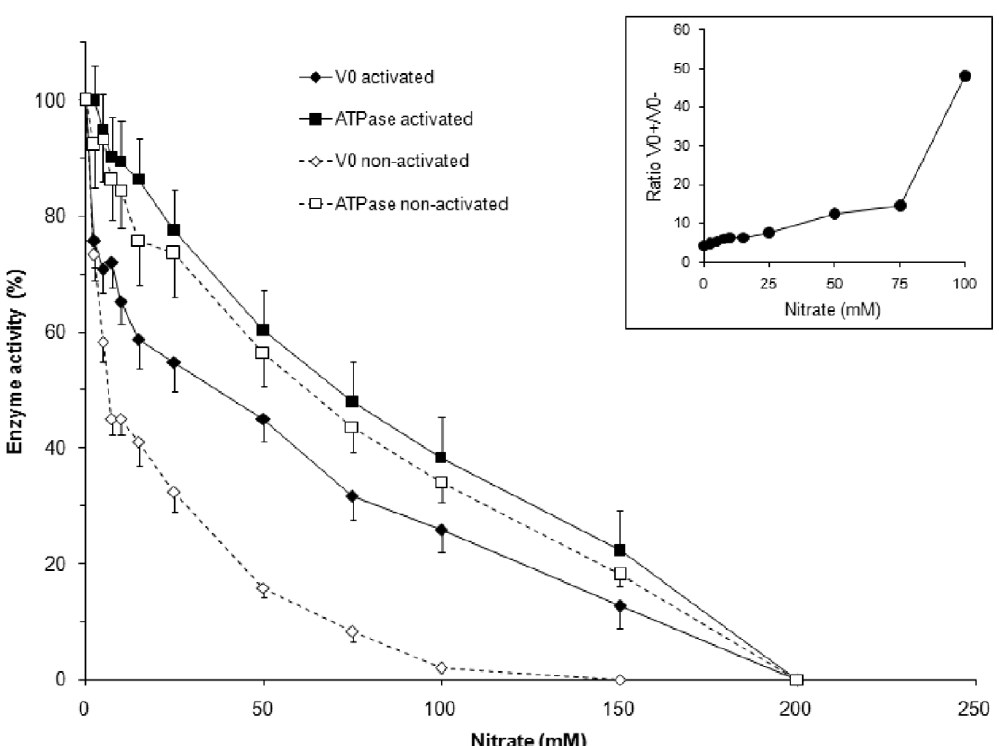
Figure 2. Nitrate inhibition of ATP hydrolysis and the initial velocity of H + transport mediated by the activated and non-activated V H + -ATPase from the total membranes of S.cerevisiae. H + transport was determined in the presence of 50 mM KCI to convert membrane potential to D pH. TM containing activated and non-activated V H + -ATPase were isolated from spheroplasts which were pre-incubated in a solution of 1.2 M sorbitol, 10 mM KH 2 PO 4 , 3 mM MgSO 4 , 10 mM Tris-HCl at pH 7.2 with or without 100 mM glucose, respectively (see Methods). The specific ATPase activities of the non-activated and activated enzymes were 0.76 and 0.46 m mol/mg 6 10 min, respectively, whereas the initial velocities were 743 6 68 and 200 6 17 percentages of the fluorescent quenching/mg 6 min. Insert : The effect of nitrate on the ratio of the initial velocities of H + - transport catalysed by the activated enzyme state (V 0 + ) and the non-activated state (V 0 2 ). The data are the mean values of at least seven independent experiments 6 SE. In each experiment, the enzyme activities were determined in triplicate.